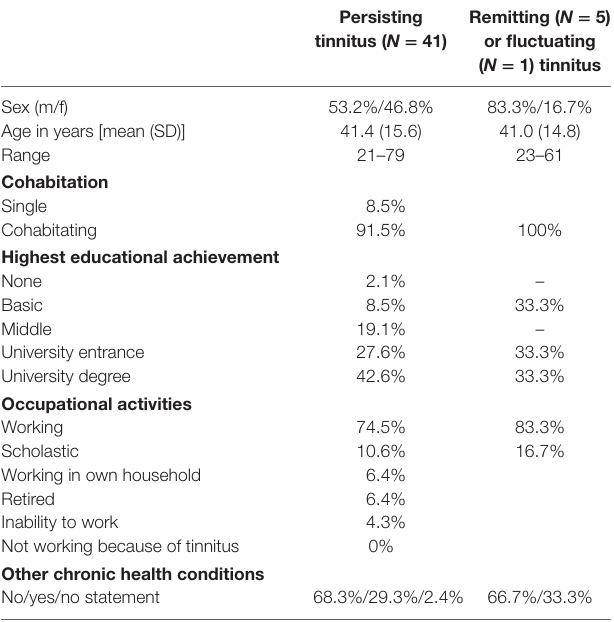
TaBle 1 | Sociodemographic factors at T1.